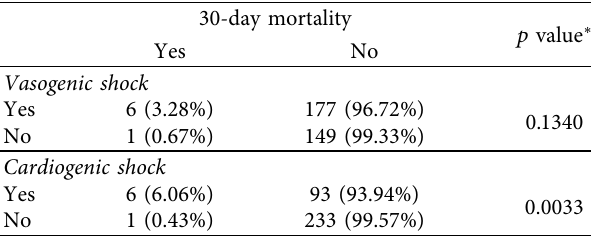
Table 3: Association of 30-day mortality and postoperative car- diogenic and vasogenic